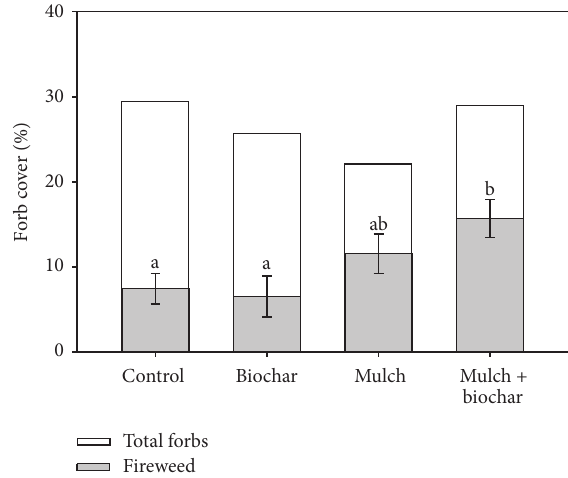
Figure 3: Total forb and fireweed (Chamerion angustifolia) cover in August 2016, the third season after post-fire rehabilitation treatment establishmentattheChurch’sParkburn,Colorado.Barsshowmeans and standard errors for fireweed sampled in six replicate treatment blocks. Letters denote significant differences among fireweed cover means at 𝛼 = 0.05